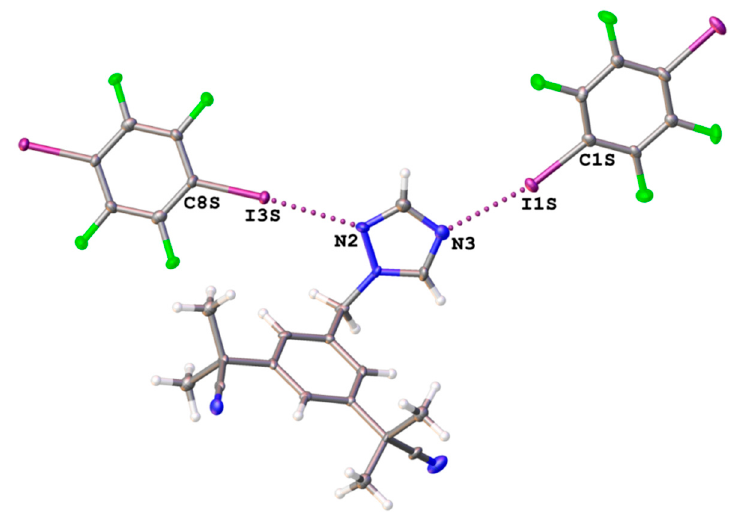
Table 1. Parameters of the C–I···X XBs in ASZ ·1.5( 1,4-FIB